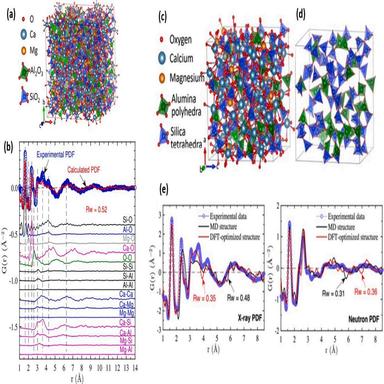
(a) Structural representation for the GGBS obtained using force-field MD simulations (box size: ~30 × 30 × 30 Å). (b) Comparison between the experimental X-ray PDF and the simulated X-ray PDF calculated using the structural representation in (a) along with the level of agreement (Rw value). Image reproduced from. A final representative structure of the CMAS glass was obtained after DFT geometry optimization. (c) The aluminosilicate network of the CMAS glass structure in (d). (e) Simulated par